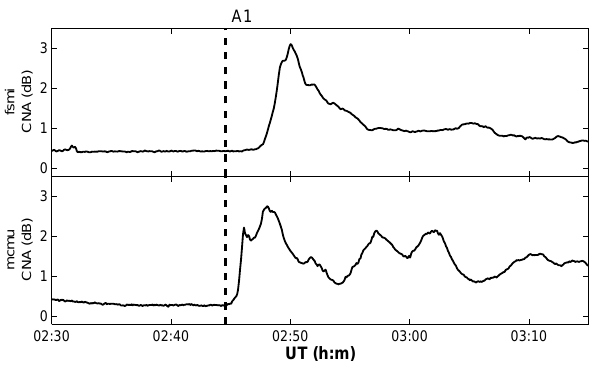
Fig. 8. Cosmic Noise Absorption from the two riometers at Fort Smith and Fort McMurray, which comprise part of the second CANOPUS meridional chain. Once again the dashed vertical lines represent the estimated times of electron injections.